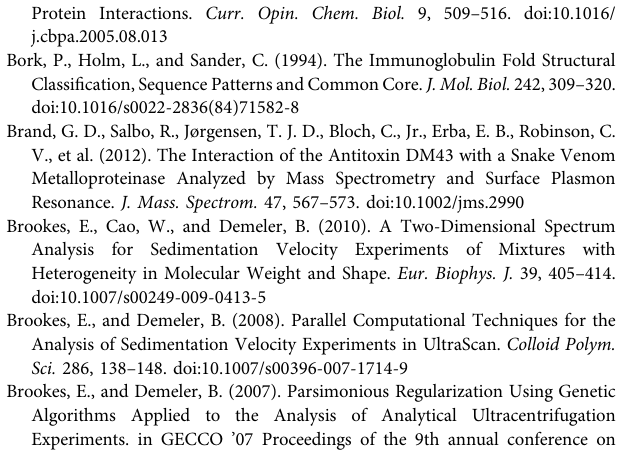
Supplementary Table S2 | Free MD hydrogen bond lifetimes in the interaction surfaces between each Ig-like domain of DM64 and myotoxin II. Supplementary Figure S1 | Analysis of complex formation between DM64 cross- linked with BS 3 and native myotoxin II. The binding property of cross-linked DM64 towardnativemyotoxinIIwasmonitoredonanon-denaturing12%Tgelstainedwith Coomassie blue R250. Lane 1: DM64 (native control); lane 2: DM64 cross-linked with BS 3 (1:2,800 mol/mol); lane 3: DM64 + BS 3 (1:2,000 mol/mol); lane 4: DM64 + BS 3 (1:1,000 mol/mol); lane 5: DM64 (native control) + mtx-II; lane 6: [DM64 + BS 3 (1:2,800 mol/mol)] + mtx-II; lane 7: [DM64 + BS 3 (1:2,000 mol/mol)] + mtx-II; lane 8: Supplementary Figure S2 | Stabilization of the complex made by the antitoxin DM64 and myotoxin II using different concentrations of BS 3 . (A) : Electrophoresis under non-denaturing conditions; (B) : Electrophoresis in the presence of SDS and DTT. All samples were run on 12% T gels stained with silver nitrate. MM: molecular Supplementary Figure S3 | Myotoxin II cross-linked with BS 3 . Ribbon diagram of myotoxin II (1CLP, chain A) showing the topologically validated cross-linking connections colored in green, the N-terminal α -helix (residues 1 to 15, colored in gray), the analogous region for calcium coordination site in catalytically active enzymes (residues 28 to 33, colored in magenta) and the myotoxic peptide (residues 100 to 121, colored in red). The active site residues His47, Tyr51, and Asp89, were represented in sticks. The cross-linking reaction was performed on myotoxin II in complex with DM64. SupplementaryFigureS4| Primarystructure oftheinhibitor DM64.Asequenceof fi ve amino acid residues was highlighted at each Ig-like domain ’ s start and end (yellow boxes). Four conserved regions formed by 12-13 amino acid residues (cyan boxes) connected sequential Ig-like domains. Except for the underlined sequences, Supplementary Figure S5 | Ribbon representation of the crystal structure of myotoxin II (1CLP, chain A) with the main structural elements highlighted in color. Myotoxin II structure is built over a helix plane formed by two long antiparallel α -helices (white). The N-terminal is structured in an α -helix (residues 1-14, gray) bent to create a small helix (residues 16 to 24, blue). The sequence analogous to the calcium coordination loop in catalytically active phospholipases A 2 was colored magenta (residues 25 to 39). Sequentially, residues from 40 to 57 form the fi rst long α -helix (white). The region from residues 58 to 73 corresponds to the frontal loop (blue) that connects to a short antiparallel β -sheet (residues 63-86,